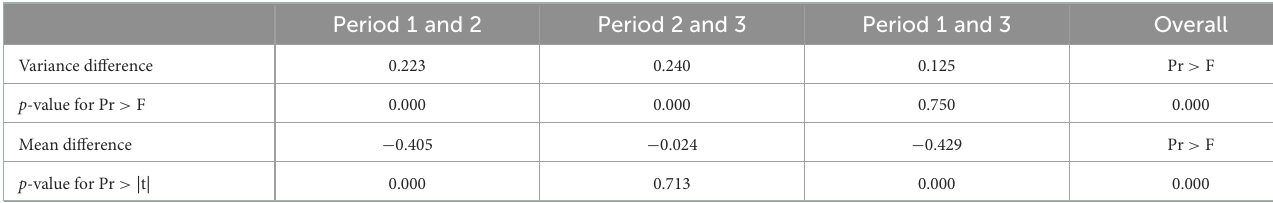
TABLE 2 Results of tests for unequal means and variances of death loss percentages. Period 1 and 2 Period 2 and